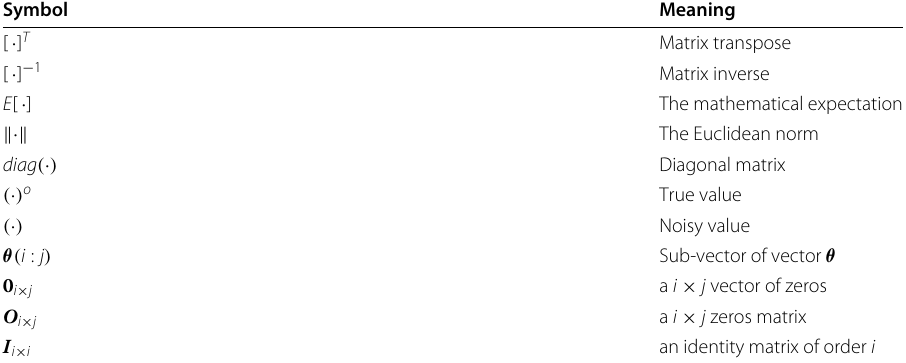
Table 1 The meaning of the notations Symbol